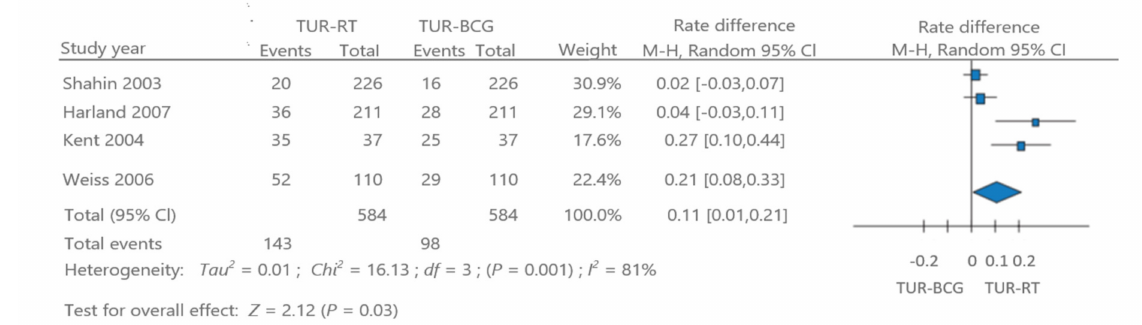
Figure 12. Overall AEs and complications in patients treated with TURBT-Radiation therapy (TUR-RT) versus in patients who received TURBT-Immunotherapy BCG (TUR-BCG), excluding all BC types and stages different than T1G3 (cross- sectional